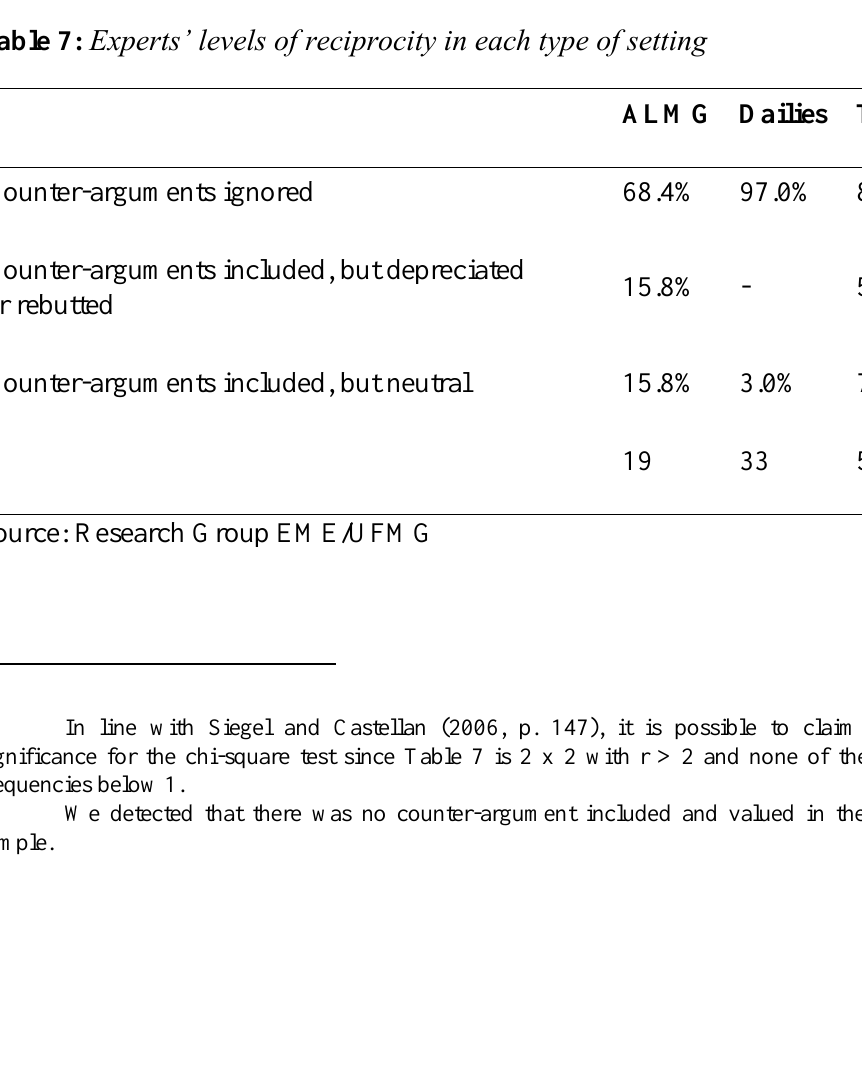
Table 7: Experts’ levels of reciprocity in each type of setting Counter-arguments